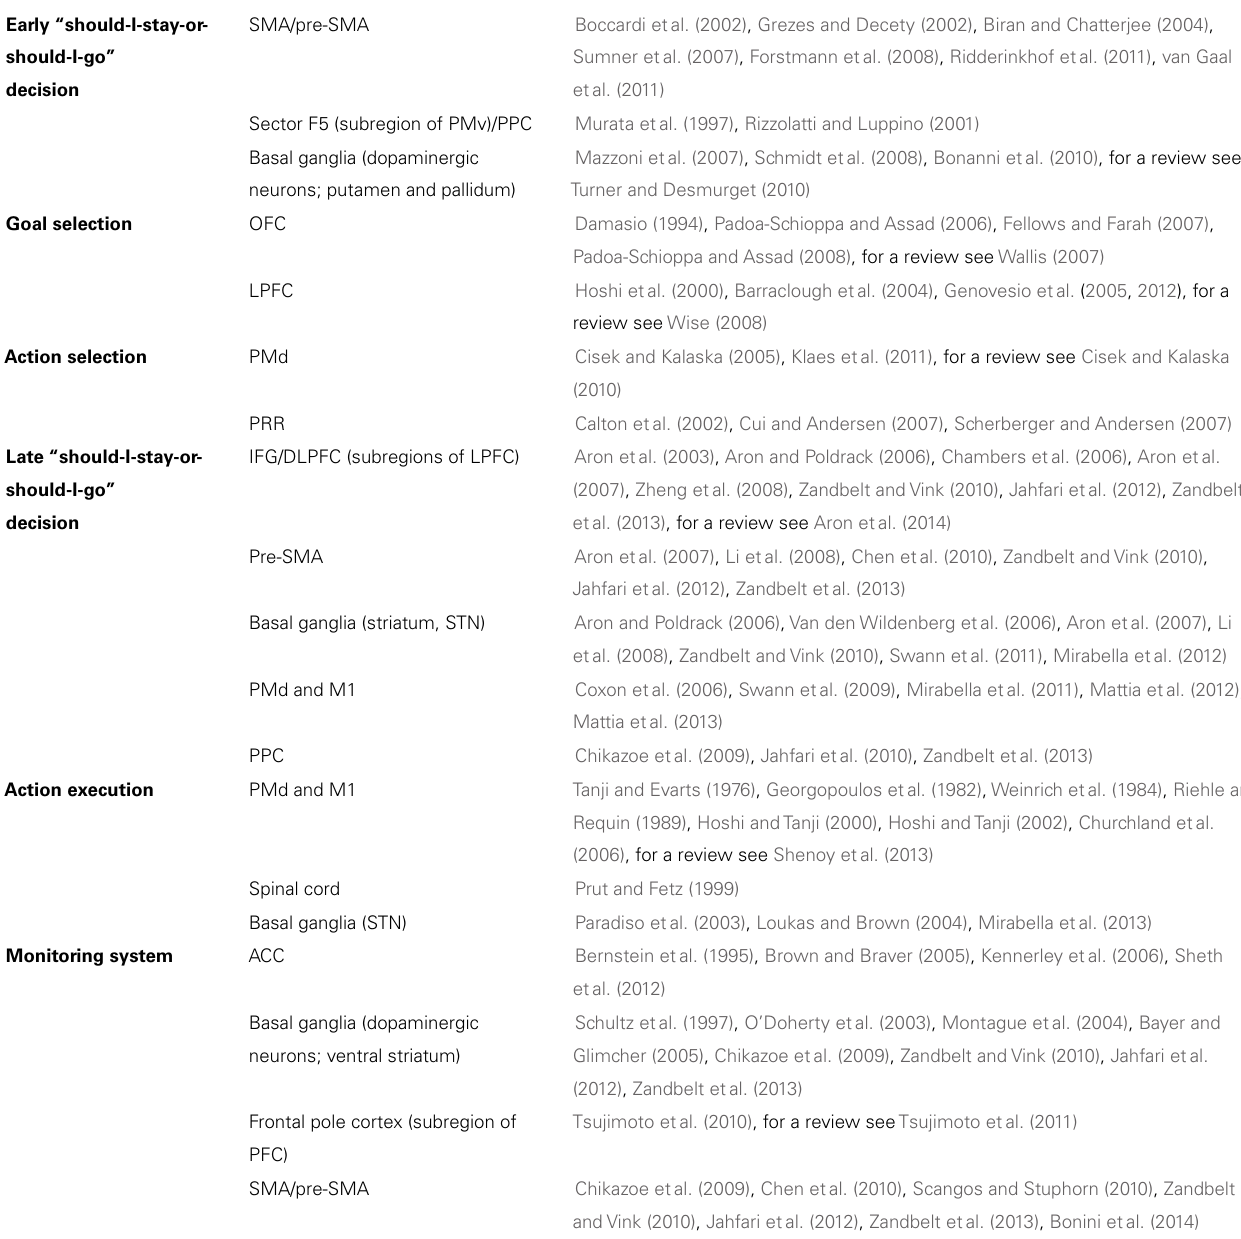
Table 1 | Summary of the main brain regions involved in each stage of the model describing the genesis of an arm goal oriented action, together with the most relevant references. Early